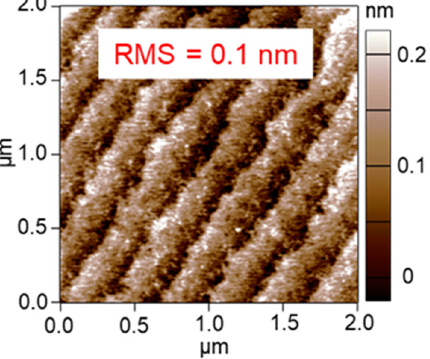
Figure 4. Widely ranged AFM image of bare Al 2 O 3 substrate after 600 °C ‐ calcination.